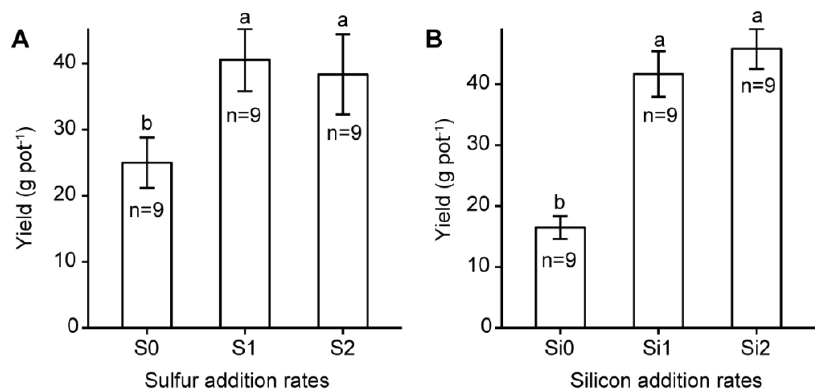
Figure 1. Effect of (A) sulfur and (B) silicon additions on rice yield. Different letters for each sulfur or silicon addition rate indicate significant differences among different treatments (Tukey HSD test, α = 0.05). Bars represent ±1 standard error ( n = 9).